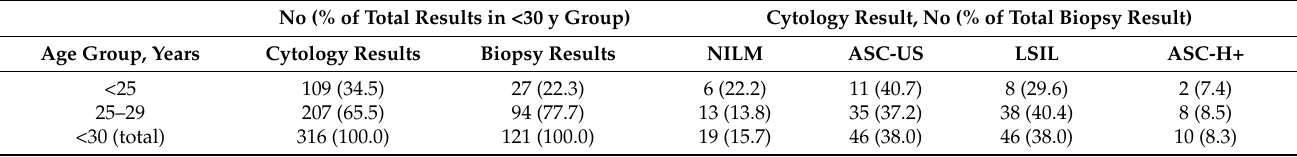
Table 8. Age-stratified (<25, 25–29 and <30 years) number of biopsy results in cytology groups.